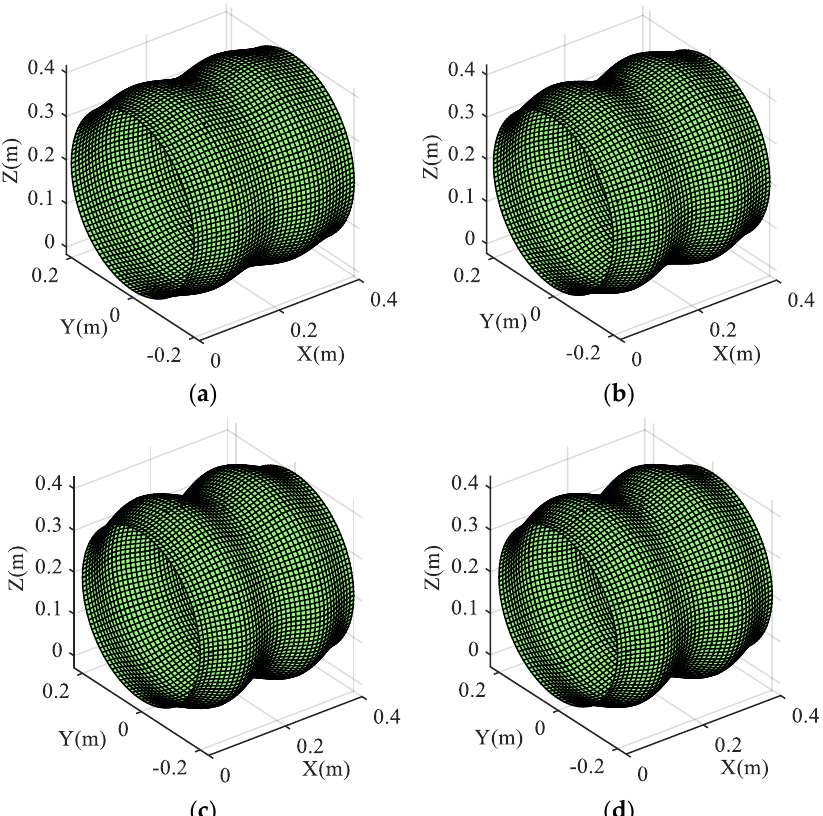
Figure 10. The shape of the cylinder at different moments. ( a ) t = 0.2 s, ( b ) t = 0.3 s, ( c ) t = 0.4 s, and ( d ) t = 0.5 s.